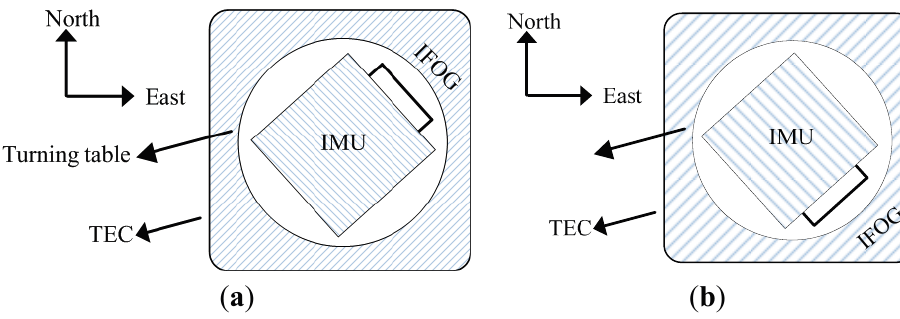
Figure 11. The placement of the tested IFOG. ( a ) The placement of NO.1 IFOG with a rotation angle A 1 = 45°; ( b ) The placement of NO.2 IFOG with a rotation angle A 2 =